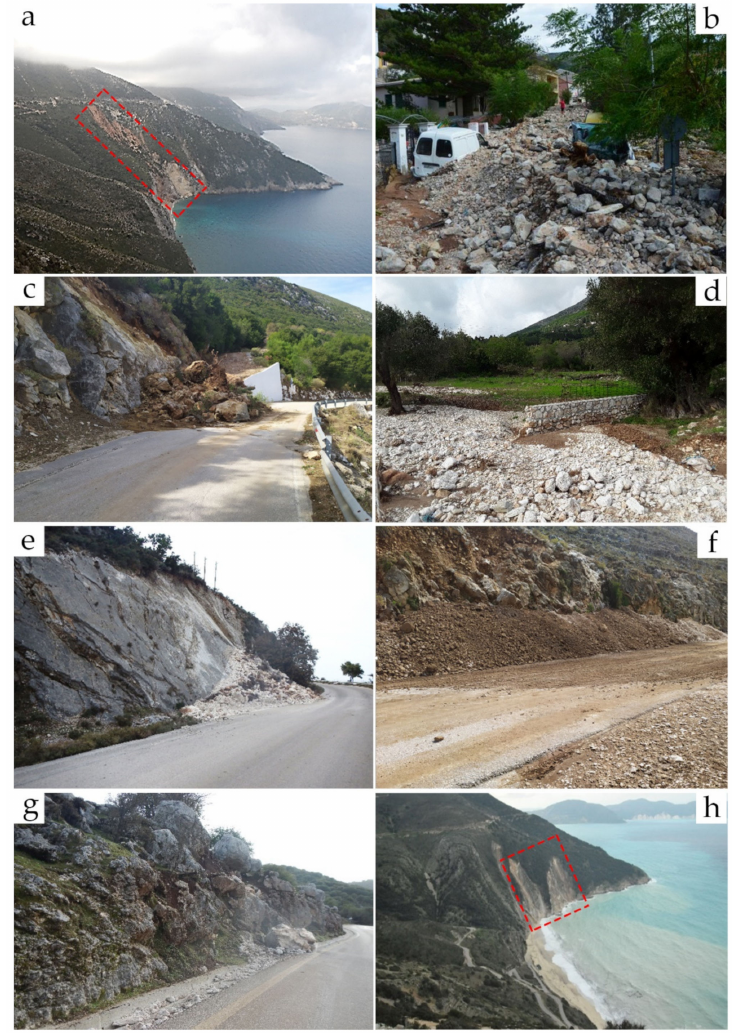
Figure 8. Characteristic images of different types of geomorphic impacts of Ianos Medicane, including ( a ) rotational slides in the western part of Cephalonia, ( b ) debris flows in Assos, ( c ) rock slides, ( d ) debris floods in Pylaros basin of Cephallonia, ( e ) debris slides, ( f ) debris falls, and ( g ) rockfalls along the road network of Lefkada, Zakynthos, and Cephalonia, as well as ( h ) complex landslides near Myrtos beach in the western part of